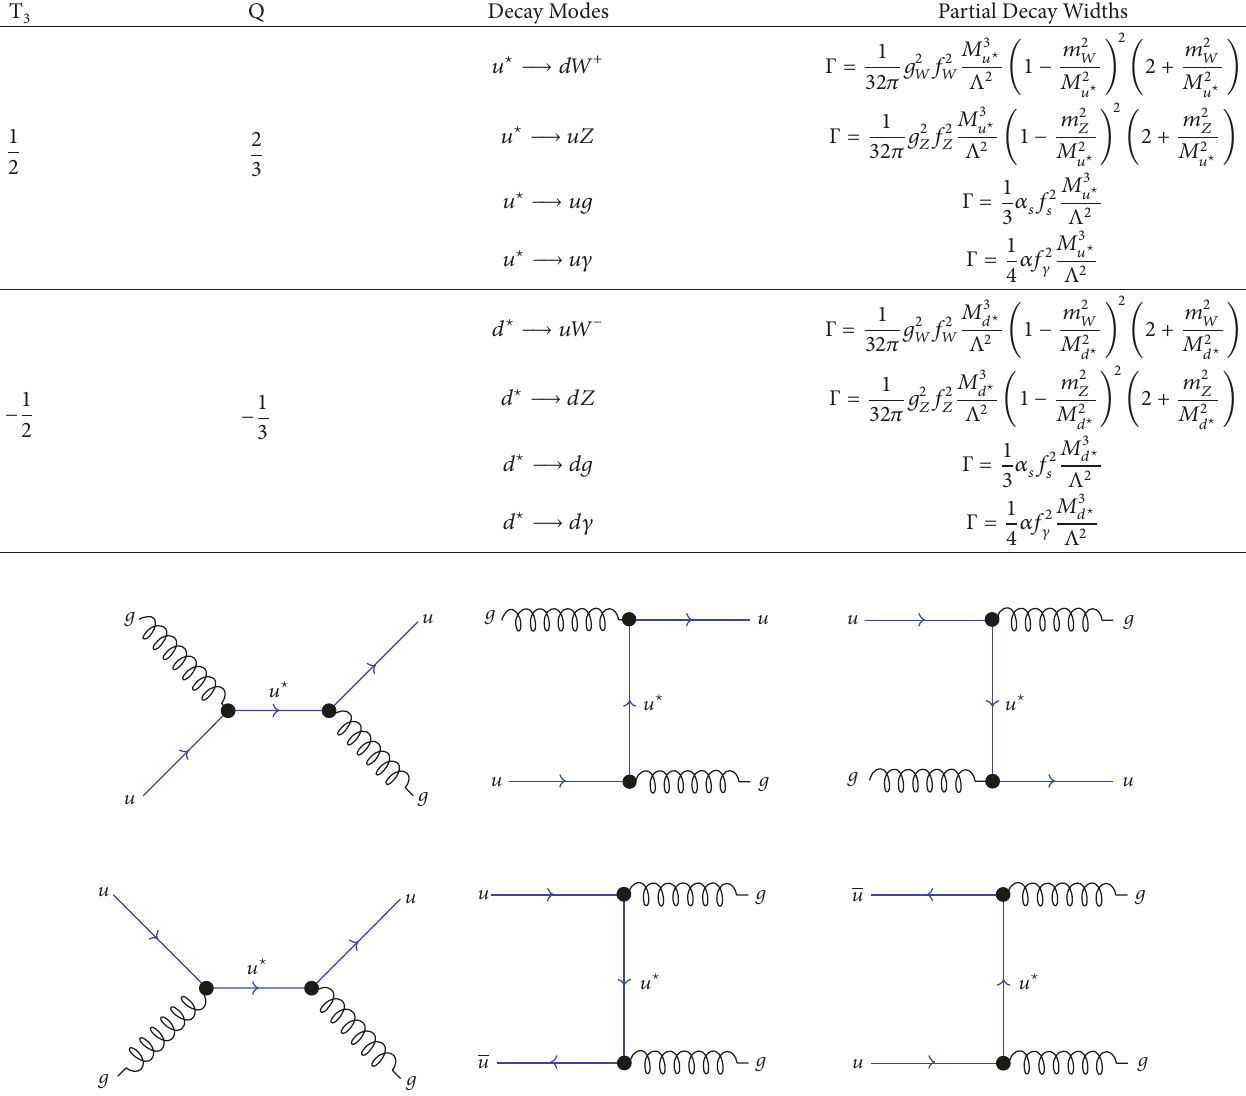
Table 2: Third component of isospins, charges, decay channels, and widths of up- and down-type excited quarks. T 3 Q Decay Modes Partial Decay Widths